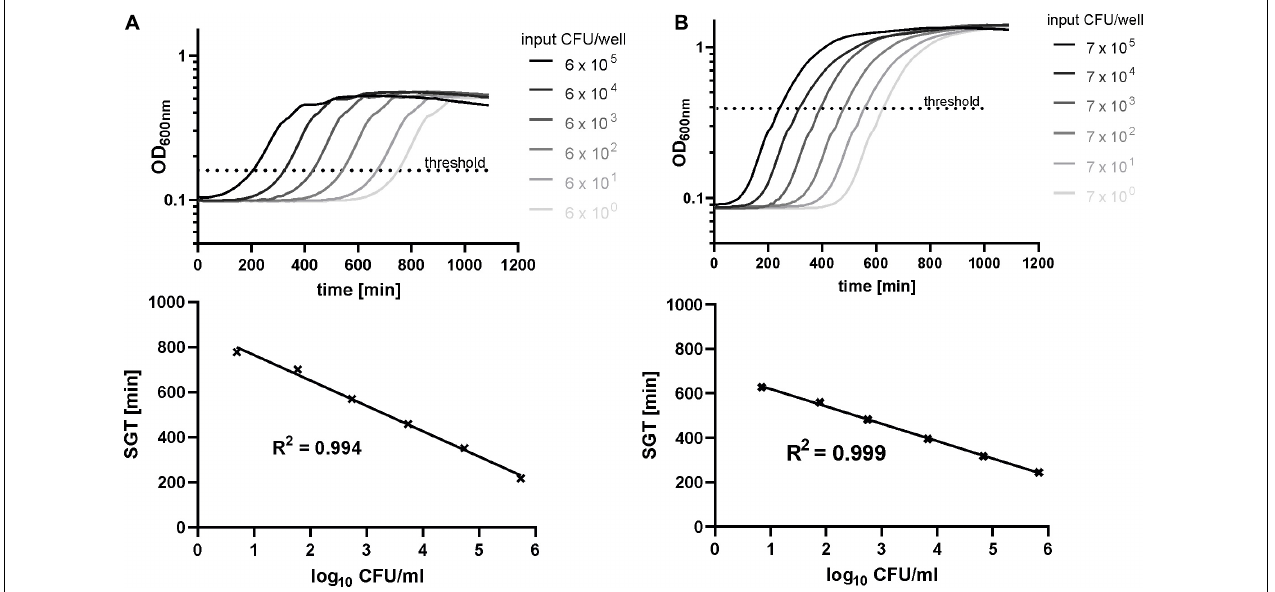
FIGURE 1 | Standard curves determined by the SGT method and agar plating for exemplary isolates of E. faecium (A) and S. aureus (B) biofilms. The optical density at 600 nm was recorded for 18 h for a dilution series of resuspended biofilms (48 h of growth). Simultaneously, CFU numbers were determined by agar